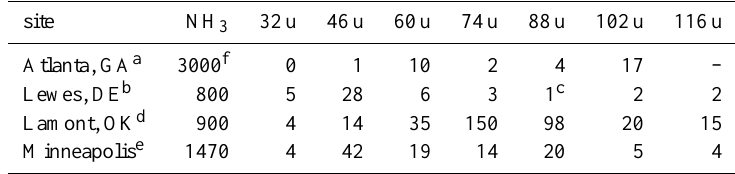
Table 3. Average ammonia and amines/amides (pptv) measured by